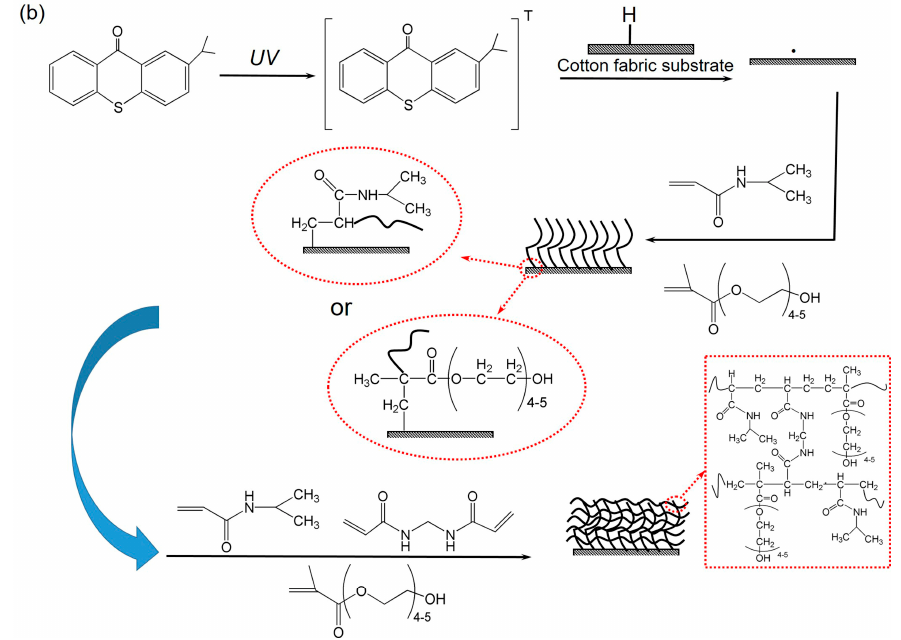
Figure 2. ( a ) UV photo-grafting method for the preparation of fabric grafted hydrogels. ( b ) Schematic illustration of the mechanism of grafting hydrogel on cotton fabrics by UV light.